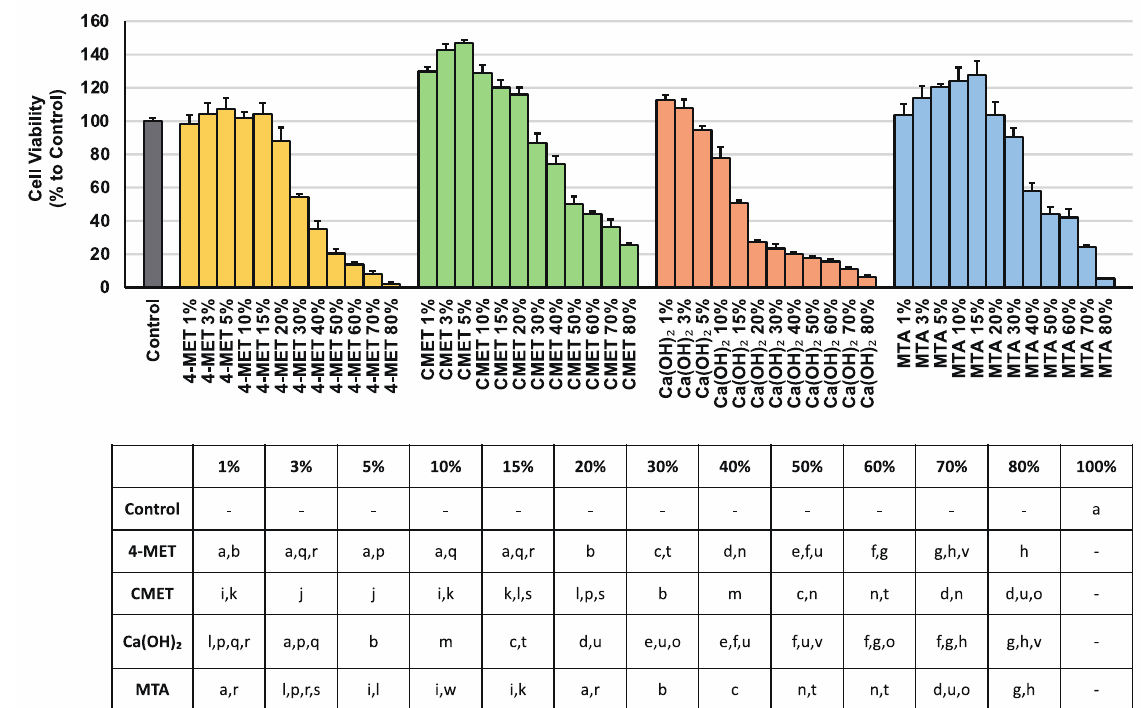
Figure 1. CCK-8 cell viability assay. Different concentrations ( v / v ) of aqueous solution of each material were added on day 1, and normal medium without the materials was used as a control. The CCK-8 assay was performed on day 4. Absorbance was measured using a microplate reader; OD = 450 nm. The viable cell ratio of the control group was accepted as 100%, and the other groups were normalized to the control to show differences by percentage compared with the baseline. n = 6, different lowercase letters indicate a significant difference ( p < 0.01).